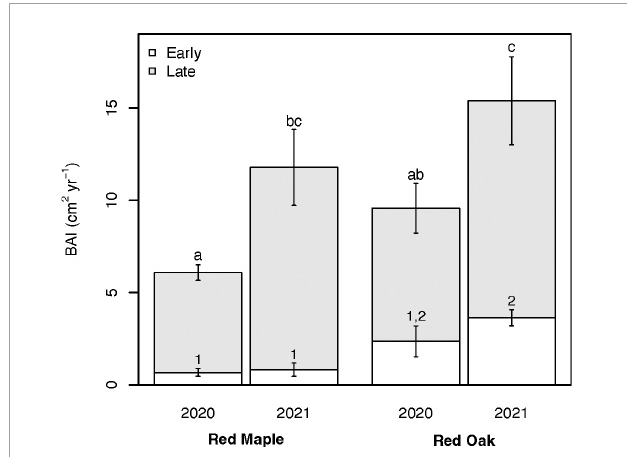
FIGURE8 Basal area increment (BAI) for red maple (left pair) and red oak (right pair) trees during 2020 (i.e., year with oak-defoliating frost) and 2021 (i.e., year without oak-defoliating frost) for the entire growing season (April–October) and the contributions from the early growing season (April–June; white) and the late growing season (July–October; gray). Error bars indicate the standard error of the mean. Different numbers and letters denote differences ( p < 0.10) in early growing season BAI and late growing season BAI, respectively. Different letters also denote significant differences in total growing season BAI. See Supplementary Tables 4A, B for summary